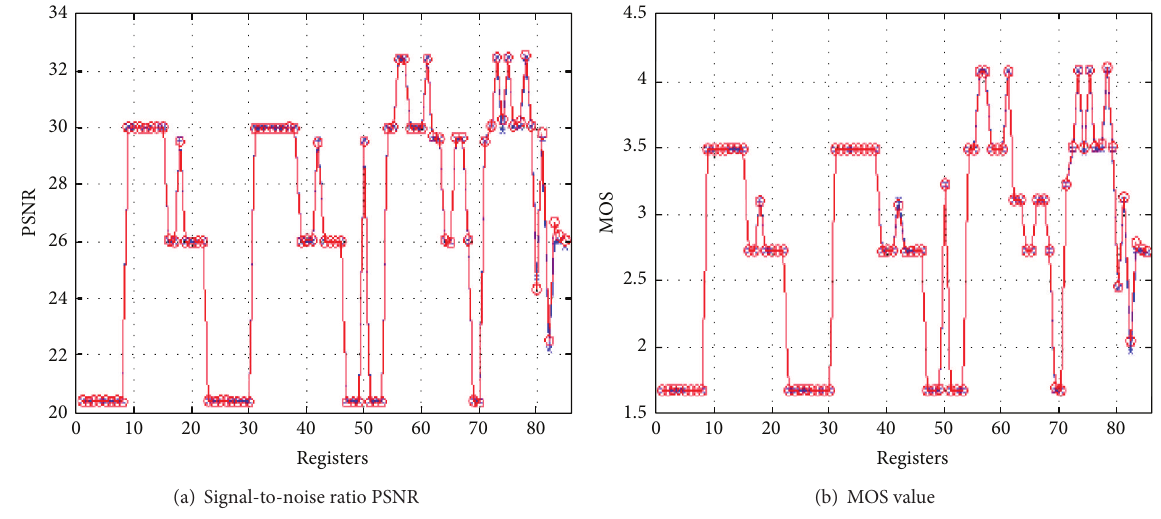
Figure 4: PSNR value and MOS value of first ninety frames.